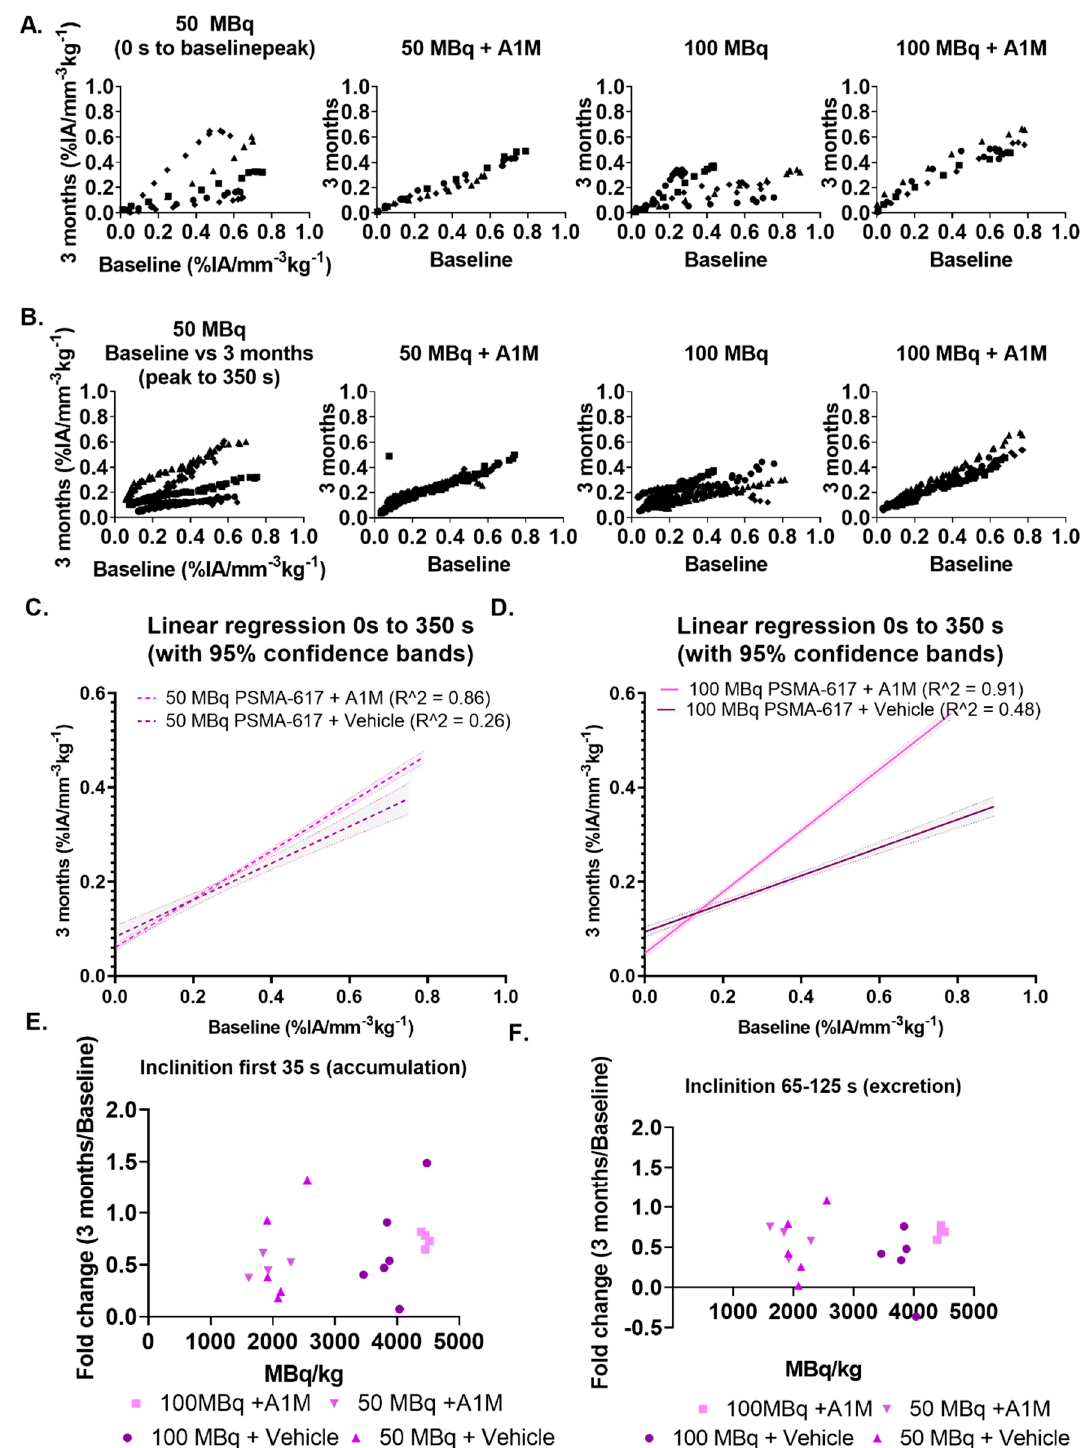
Figure 4. Three months [ 99m Tc]Tc-MAG3 activity data normalized to each corresponding individual baseline [ 99m Tc]Tc- MAG3 activity data. ( A ) The normalized initial uptake phase for rA1M and vehicle treated groups. ( B ) The normalized excretion phase. ( C ) Linear regression of the normalized SIU values and normalized excretion phase for 50 MBq [ 177 Lu]Lu- PSMA-617. ( D ) Linear regression of the normalized SIU values and normalized excretion phase for 100 MBq [ 177 Lu]Lu- PSMA-617. ( E ) Normalized slope of the accumulation phase when plotting these values vs. activity concentration MBq/kg. ( F ) Normalized slope of the excretion phase.